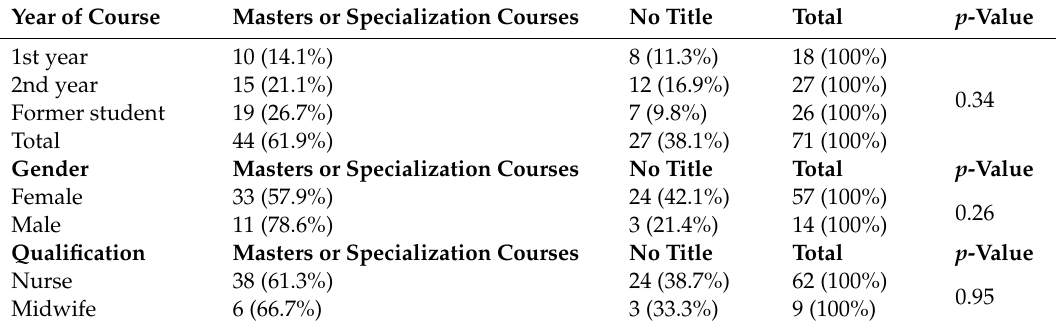
Table 3. Frequency distributions (values and row percentages) and p -value (Yates’s chi-squared test) of sample’s postgraduate training, stratified by year of course, gender and professional qualification.